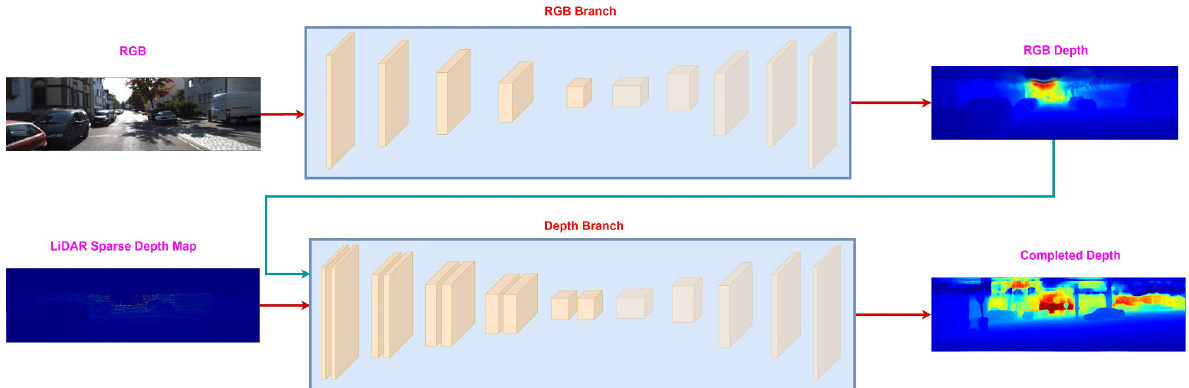
Figure 4. Sequential fusion between RGB image and LiDAR sparse depth map. The RGB branch produces color depth, which along with LiDAR sparse depth map, is sent to the depth branch to estimate the final dense depth map.